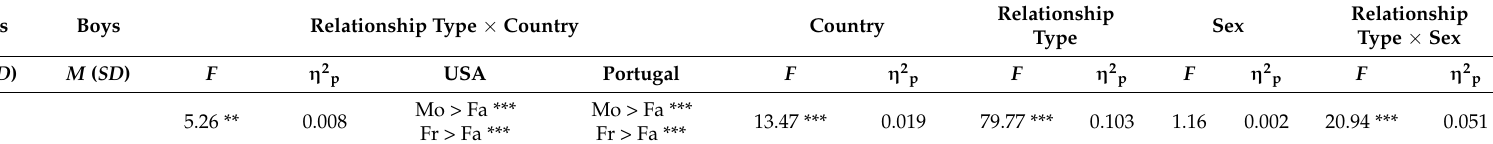
Relationship Relationship Sex Type × Sex Type